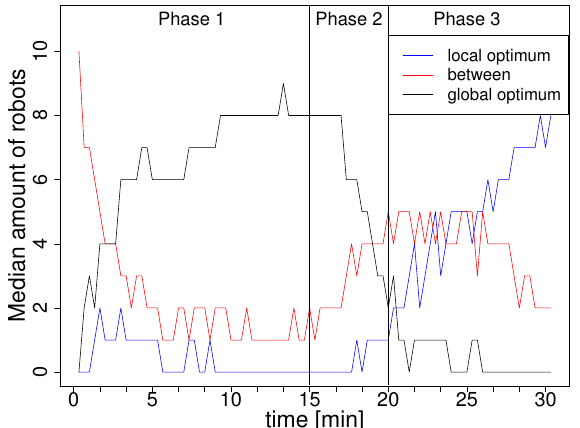
Figure 5: Course of experiment in the dynamic envi- ronment: Median number of robots in the different areas and